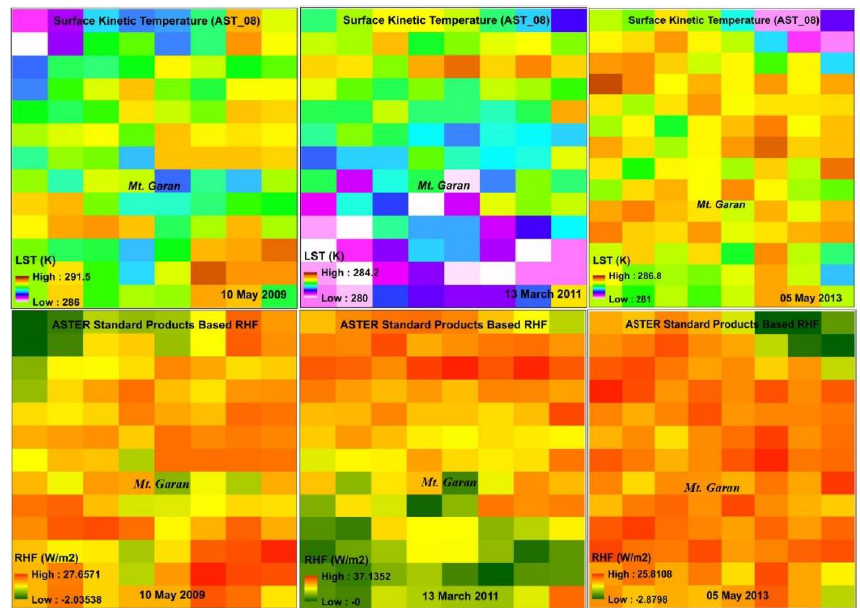
Figure 18. High level ASTER product of surface kinetic temperature (AST_08) of the Mt. Garan fumaroles from 2009 to 2013 ( top row ). RHFs are retrieved from the ASTER standard products of emissivity (AST_05) and surface kinetic temperature (AST_08) from 2009 to 2013 of the Mt. Garan fumaroles, shown in the bottom row .